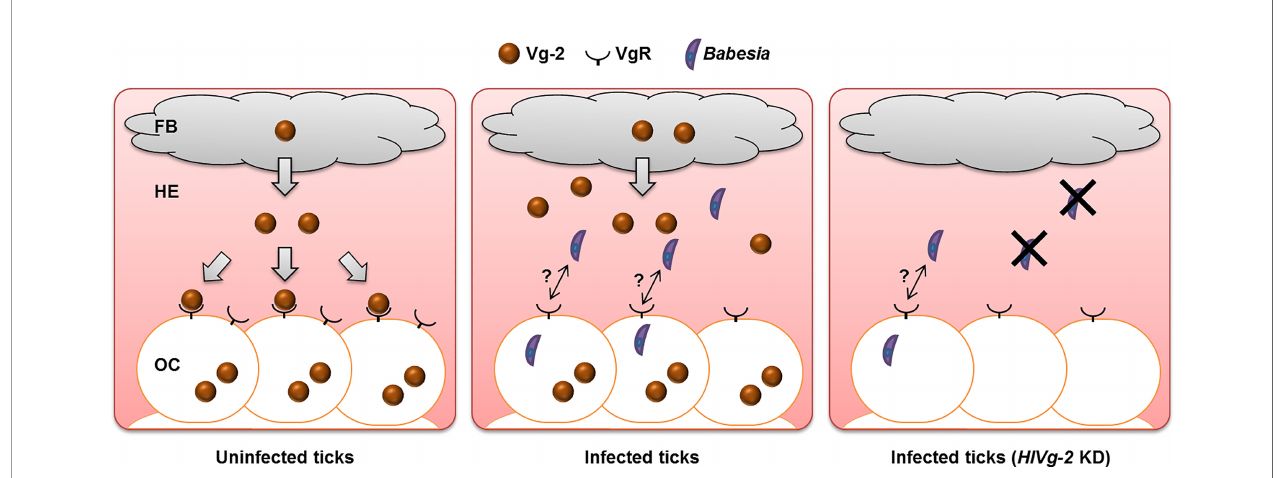
FIGURE 6 | Babesia transmission model at the early phase of preovipositional period in parthenogenetic H. longicornis . In uninfected ticks, Vg-2 synthesized in the fat body is released into the hemolymph and is taken up by oocytes via VgR. In the presence of Babesia , Vg-2 accumulates in both the fat body and hemolymph. Although Vg-2 uptake via VgR from the hemolymph is suppressed, Vg-2 is synthesized within oocytes for their development. In Vg-2 KD ticks, the amount of Babesia in the hemolymph decreased, but some Babesia invaded oocytes. FB, fat body; HE, hemolymph; KD, knockdown; OC, oocyte; Vg-2, vitellogenin-2; VgR, vitellogenin